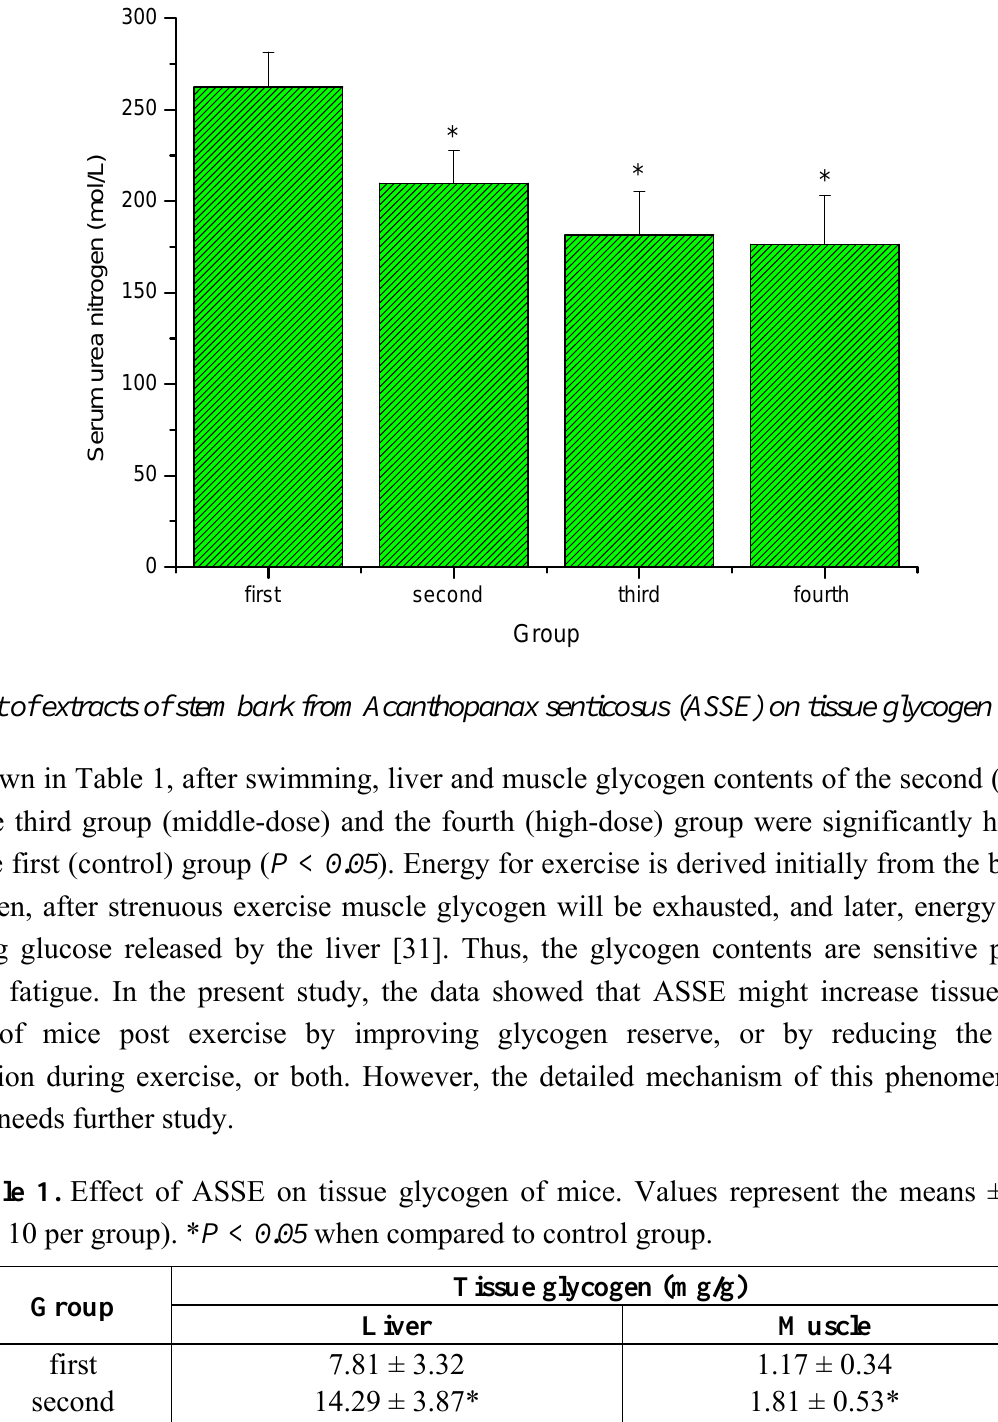
Figure 4. Effect of ASSE on serum urea nitrogen of mice. Values represent the means ± SE (n = 10 per group). * P < 0.05 when compared to control group.